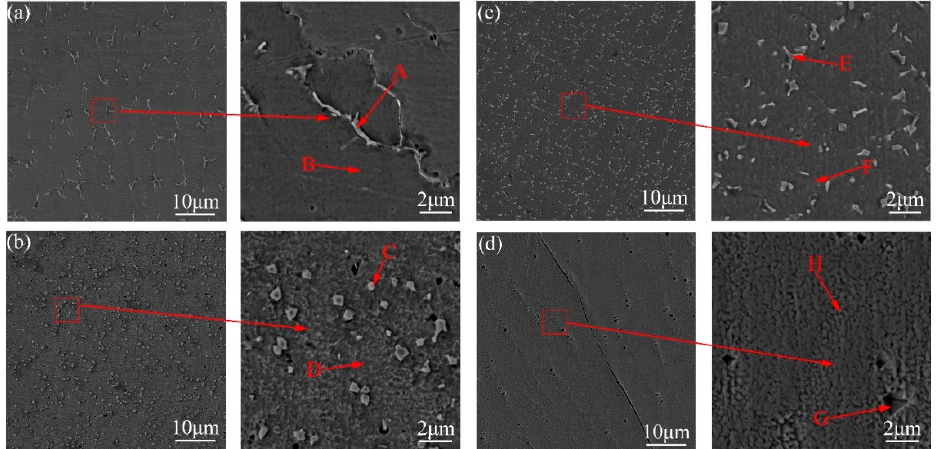
Figure 4. Microstructure of four kinds of laser cladding layers (1600 W, 15 mm/s and 0.8 mm of thickness). ( a ) Ni 107; ( b ) Ni 183; ( c ) Ni 202; ( d ) Ni 307.